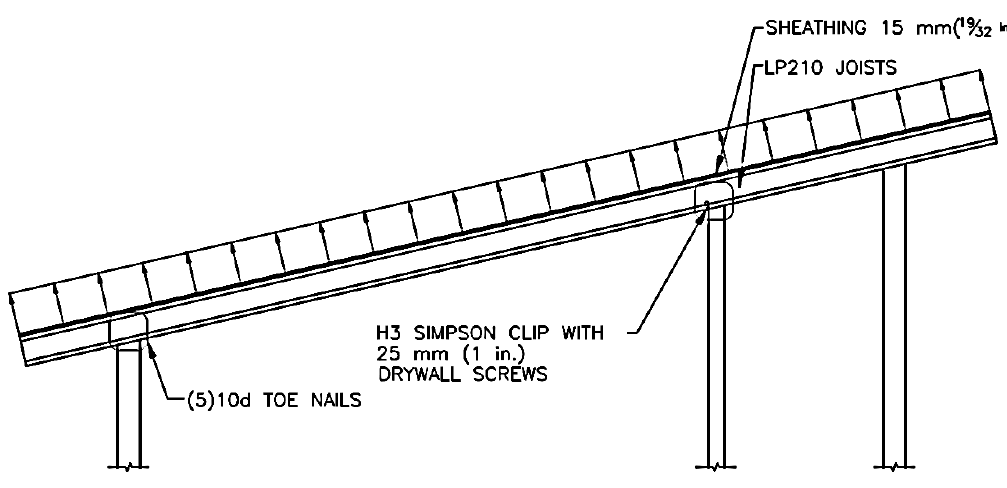
Figure 7. Roof uplift